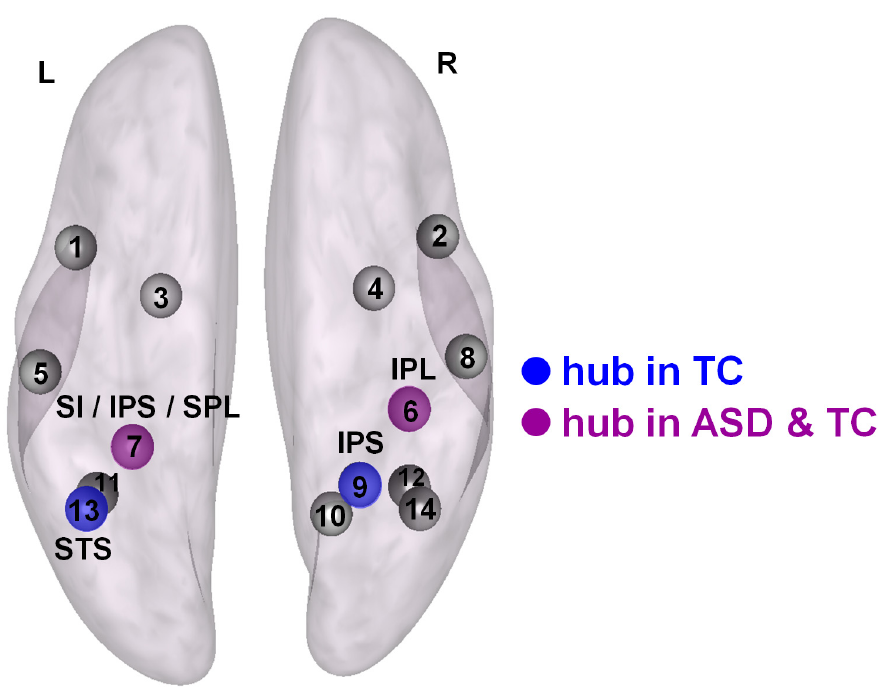
Fig 3. Identification of network hub nodes based on the graph theoretical network analysis using fixed cost thresholds. Hubs identified in both groups (ASD and TC) are indicated in purple. Hubs identified only in the TC group are indicated in blue. No hubs were identified only in the ASD group. L: left, R: right, IPL: inferior parietal lobule, SI: primary somatosensory cortex, IPS: intraparietal sulcus, SPL: superior parietal lobule, STS: superior temporal sulcus. Numbers correspond to the regions listed in Table